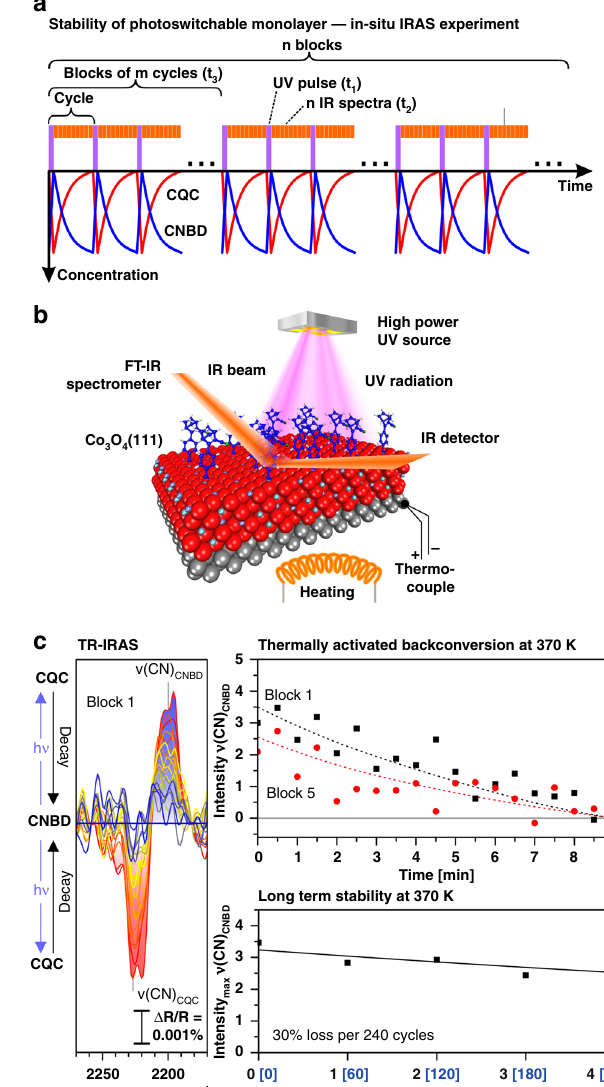
Fig. 5 Stability of the CNBD monolayer on Co 3 O 4 (111) during (back-) conversion: a the experimental procedure of repeated photochemical conversion and thermally activated backconversion and ( b ) experimental setup used in the in-situ IRAS experiment; c IR spectra in the CN stretching frequency region of CNBD and CQC during photochemical conversion and thermally activated backconversion and development as a function of time, referenced to the anchored CNBD monolayer (black squares: block 1, red circles: block